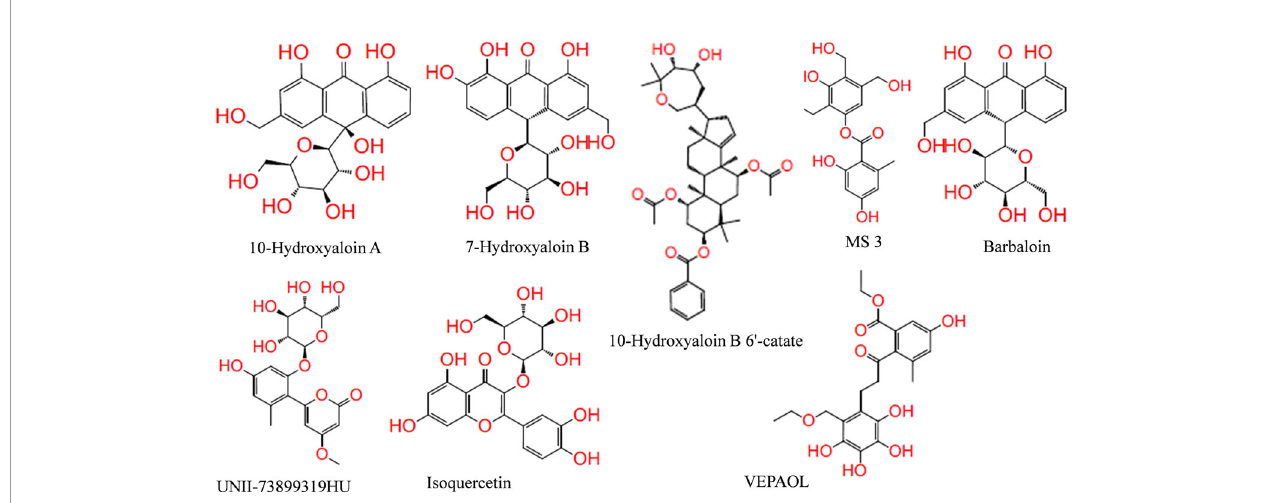
FIGURE 1 | Structure of lead phytochemicals present in Aloe vera and Azadirachta indica having potential to bind at the active sites/protein binding sites of the SARS-CoV-2 drugable Figures 3B – D . Asp422 residue of Spike protein S1 domain was involved in hydrogen bond formation with the VE607. Besides,